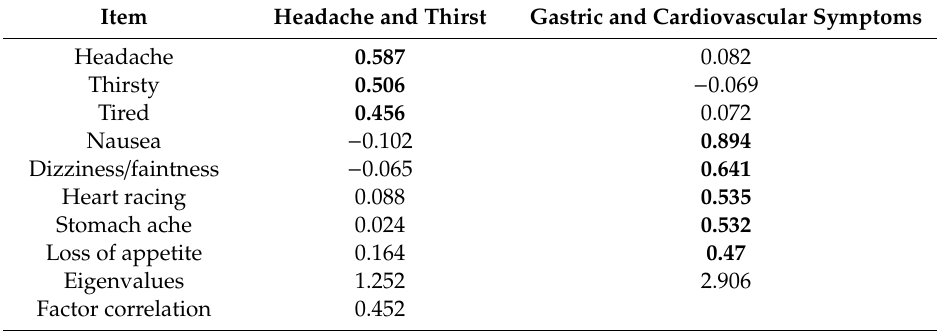
Table 3. Factor loadings of AHS items based on principal axis